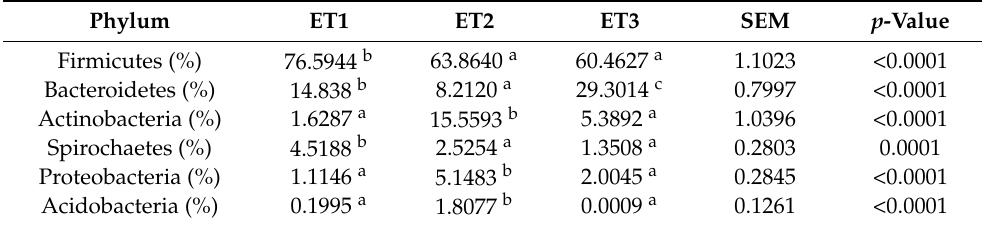
Table 2. Differentially abundant bacterial phyla in three enterotypes.